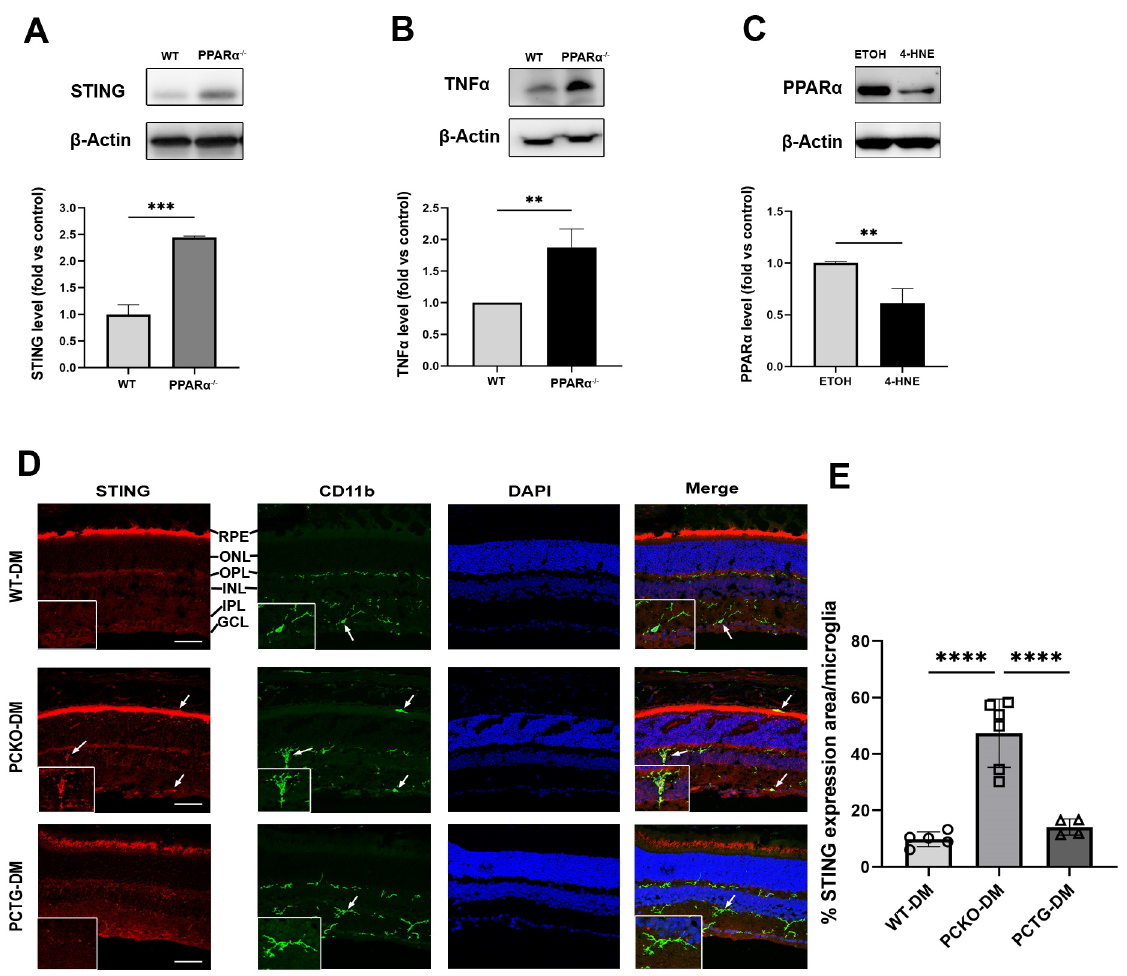
Figure 7. Increased cytokine release in microglia with PPAR α deletion. ( A , B ) STING and TNF α protein levels in primary WT and Ppar α − / − microglial cells. n = 3. ** p < 0.01, *** p < 0.001, Student’s t -test. ( C ) PPAR α protein levels as quantified by Western blot analysis in HMC3 cells following 24 h 4-HNE exposure. n = 3. ** p < 0.01, Student’s t -test. ( D ) STING/CD11b co-immunostaining (arrows) in WT-DM, PCKO-DM, and PCTG-DM retinas. Scale bar: 50 µ m. ( E ) Quantification of STING expression per microglial cell. n = 4 − 6. **** p < 0.0001, One-way ANOVA with Tukey’s posthoc comparison. Data are presented as mean ±